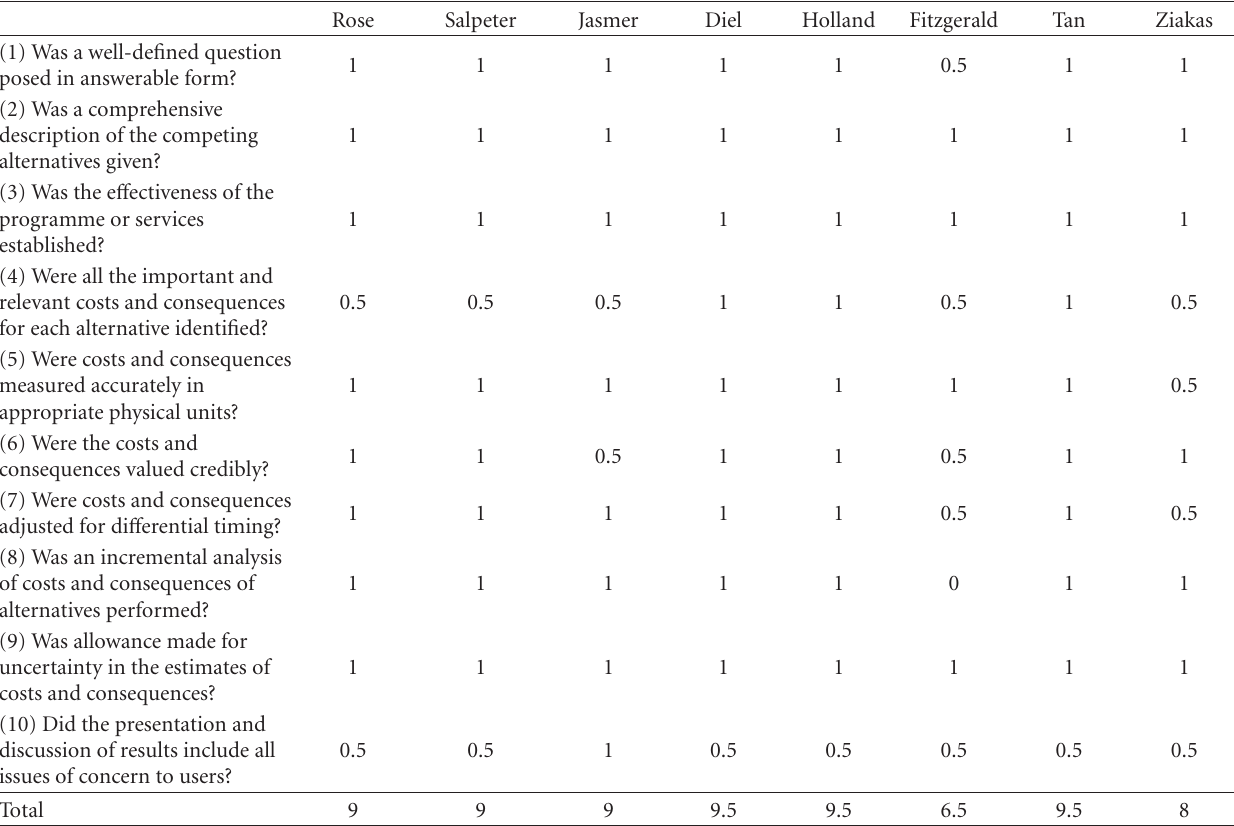
Table 2: Checklist of best practice in economic evaluation